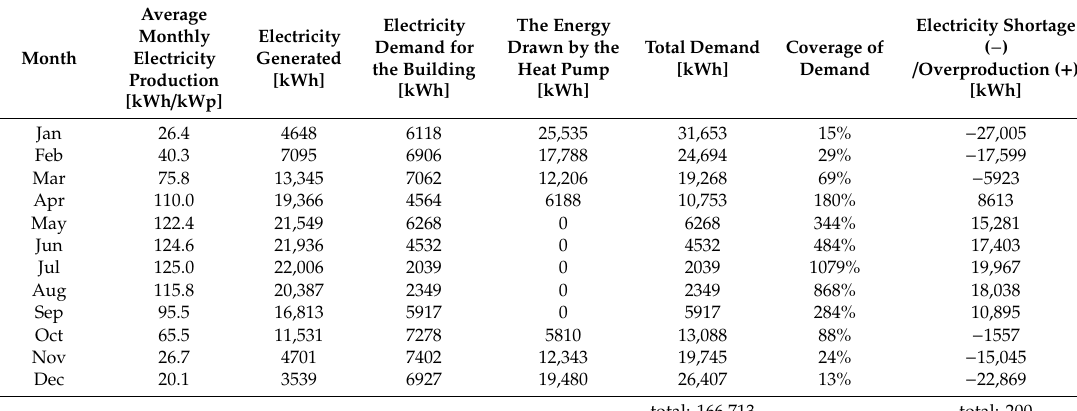
Table 2. Coverage of the electricity demand, including the heat pump, by an installation ensuring zero energy balance of the